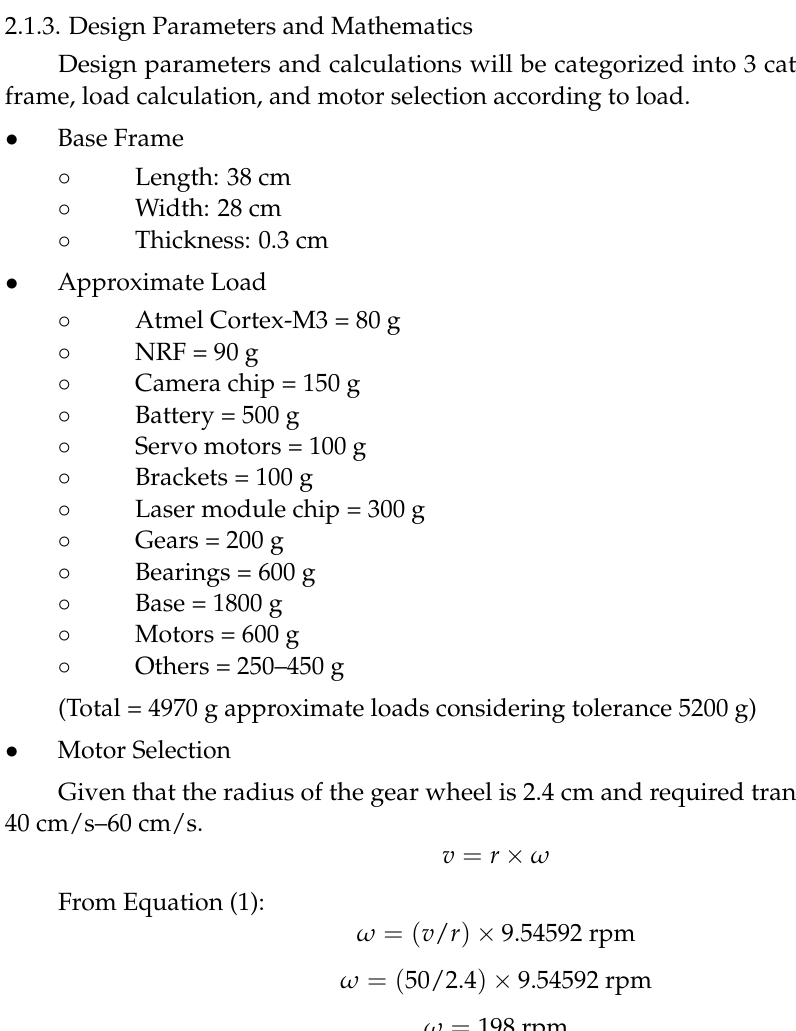
Figure 14. Atmel Cortex